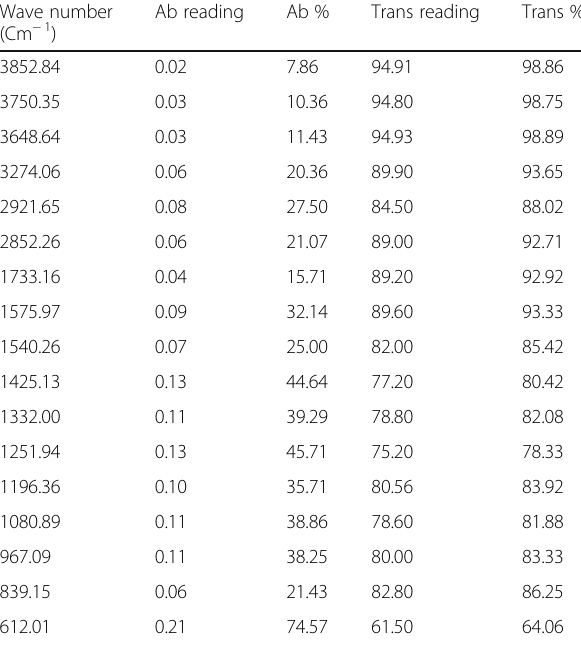
Table 6 The FT-IR measurements showing absorbance and transmittance of the bioactive compounds in the M. oleifera leaves extract after incorporating Ag-NPs Wave number (Cm − 1